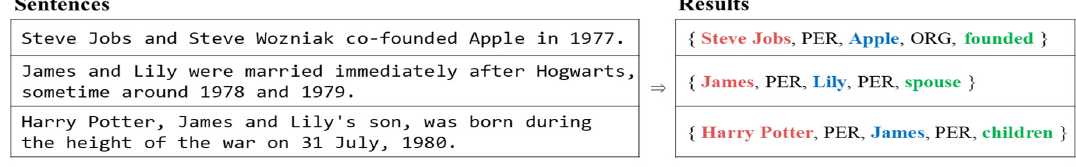
Figure 1. A motivating example of DeNERT-KG.